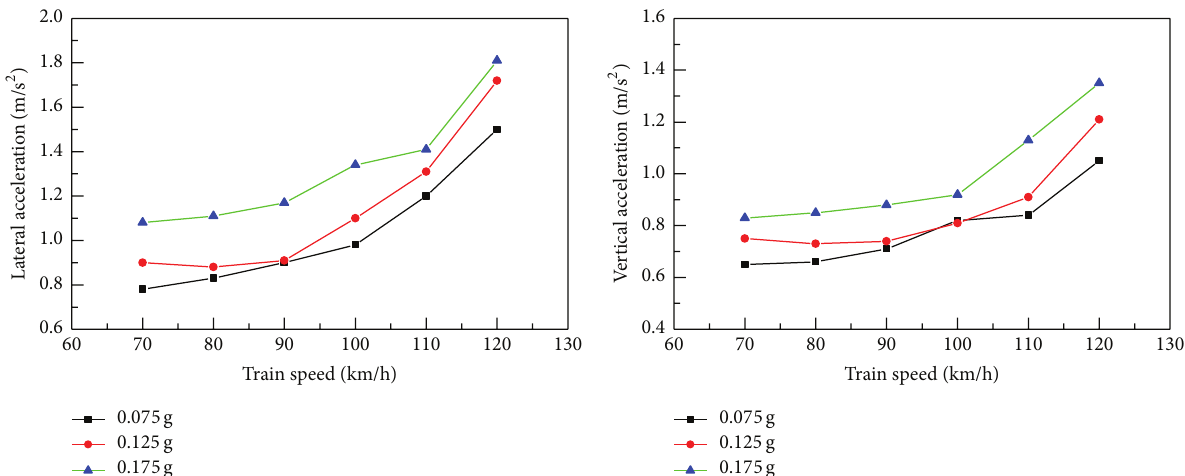
Figure 13: The maximum responses of lateral acceleration and vertical acceleration of the first car